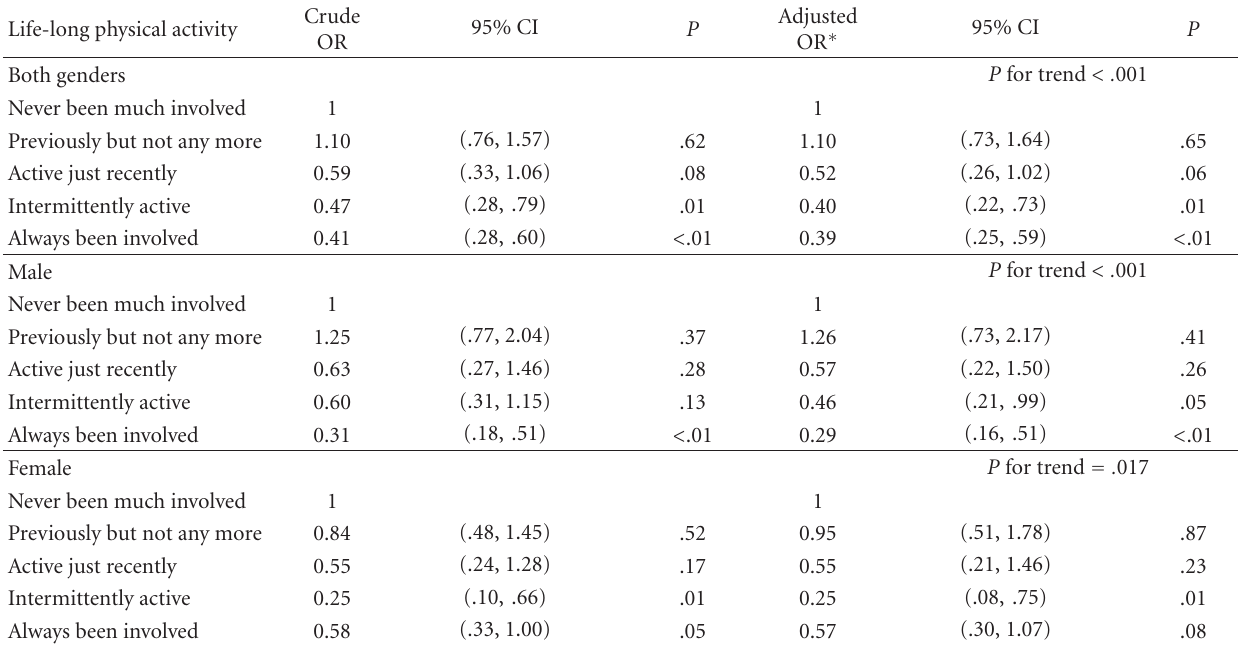
Table 2: Life-long physical activity and risk of ischemic stroke in southern